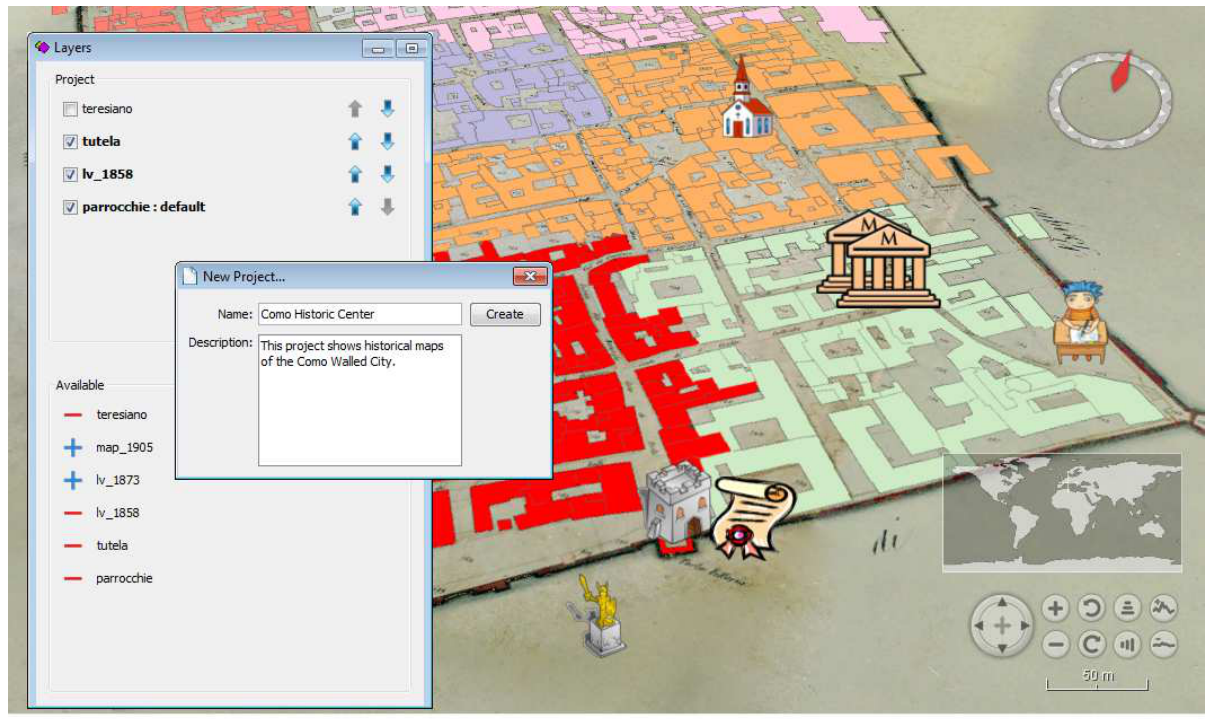
Figure 6. Creation of a sample project composed of the mash-up between the POIs and other WMS